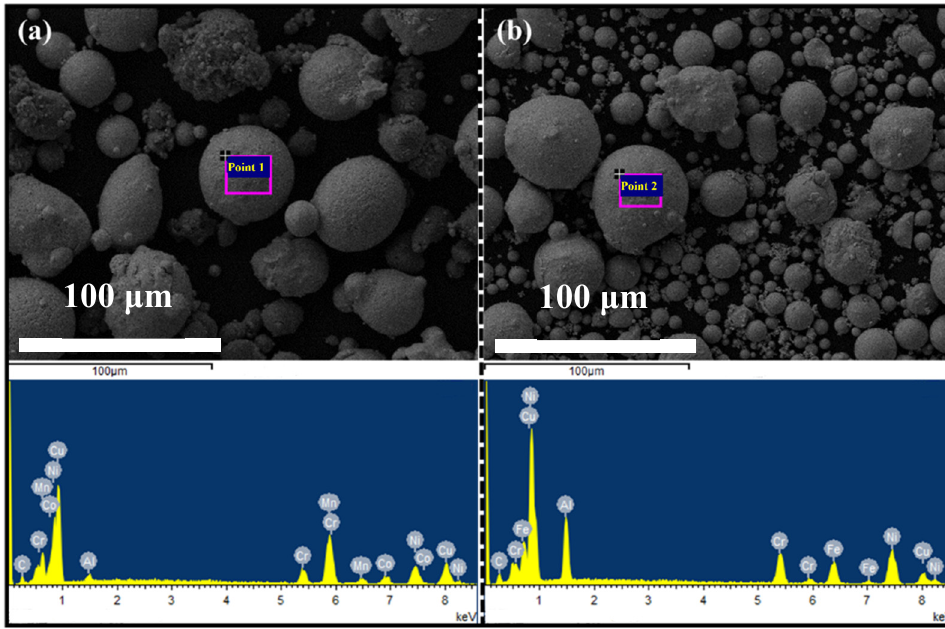
Figure 7. SEM morphology and EDS results of ( a ) 3# and ( b ) 4# high entropy alloy powders.